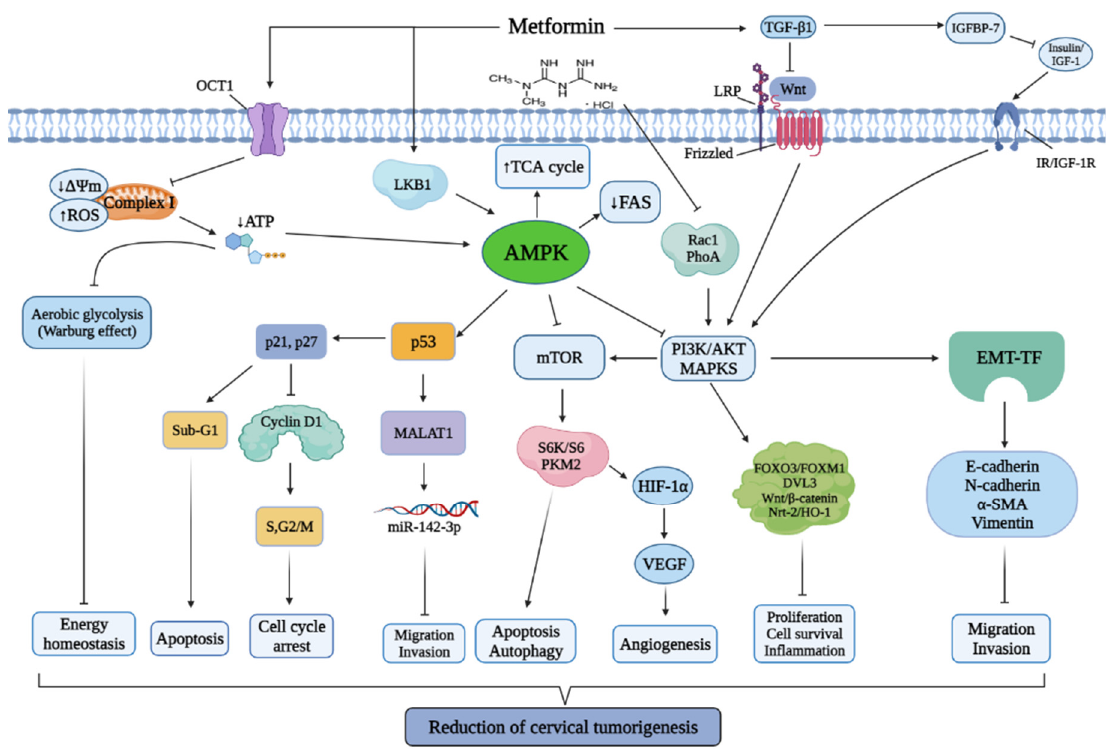
Figure 1. Anticancer molecular mechanisms of metformin in cervical cancer. Metformin mainly modulates AMPK activation through LKB1, which activates or inactivates various downstream signaling targets, such as p53, mTOR, PI3K/Akt, MAPKs, TGF- β 1, IGF-1, and transcription factors (FOXO3a, DVL3, Wnt/ β -catenin, HIF-1 α ). The activation of these signaling pathways induce cell cycle arrest, apoptosis, and autophagy that inhibit tumorigenesis in the cervical cancer cell while suppressing cellular migration, invasion, angiogenesis, inflammation, and cell